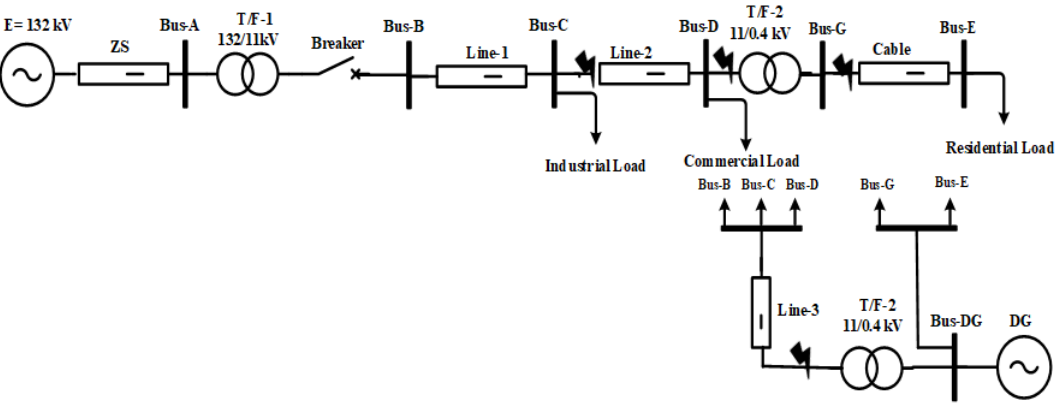
Figure 2. One line diagram of the test